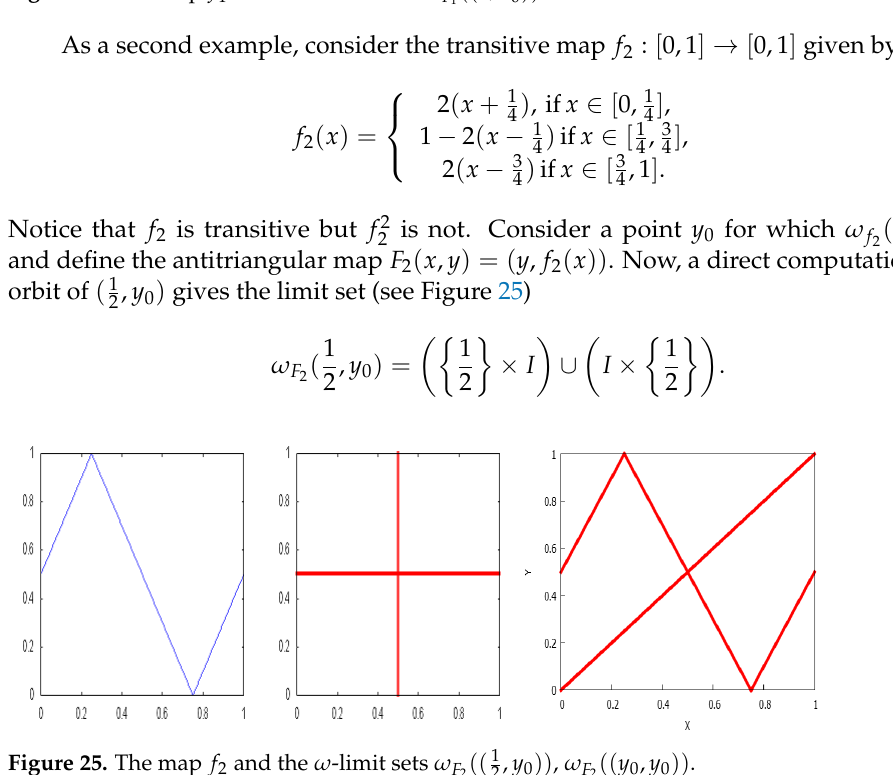
Figure 24. The map f 1 and the ω -limit set ω F